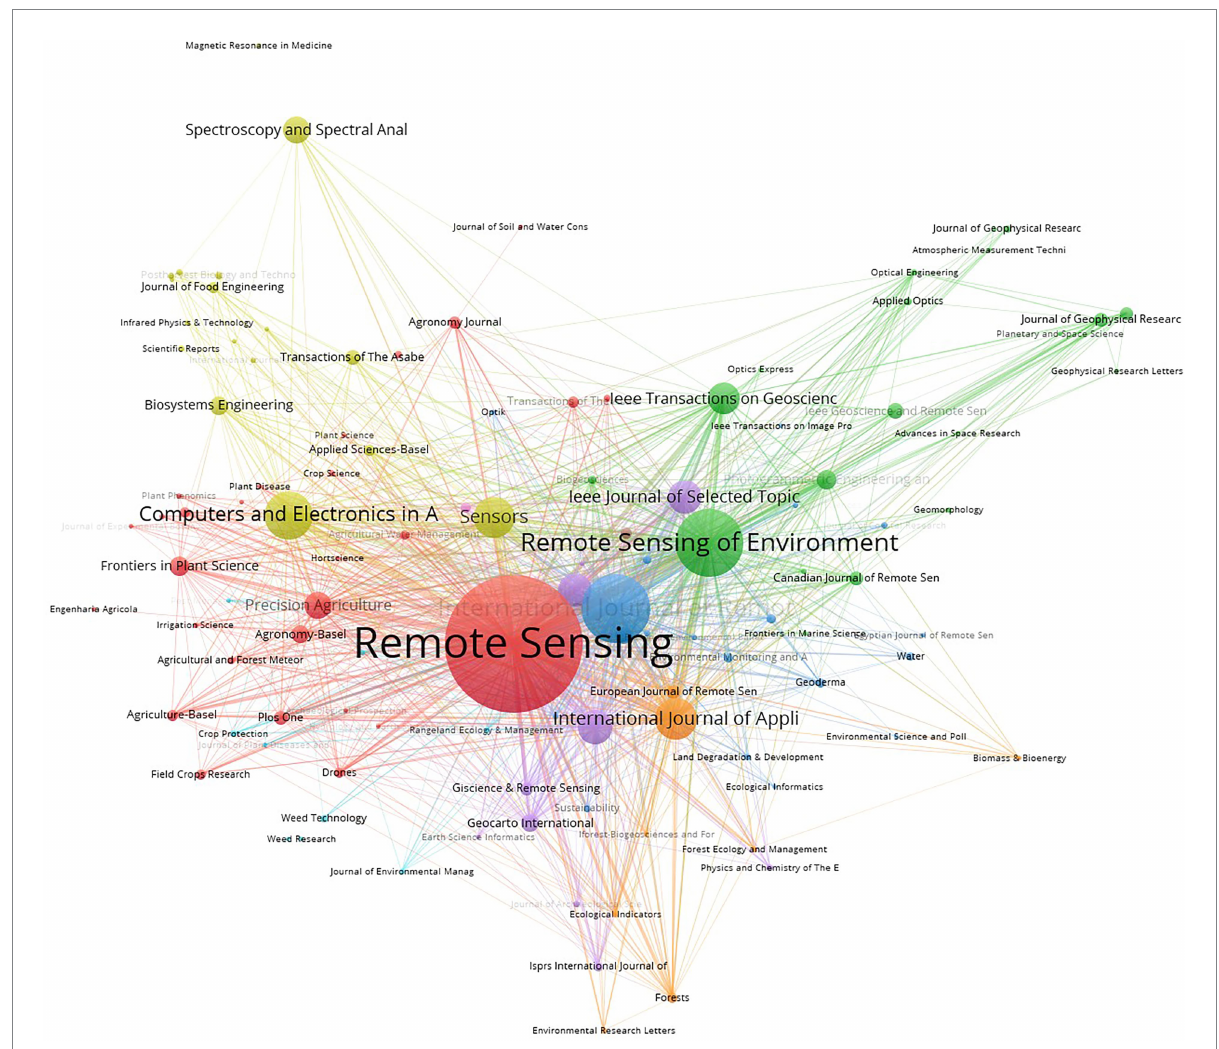
FIGURE 4 Co-occurrence map of influential journals on agricultural multispectral research in